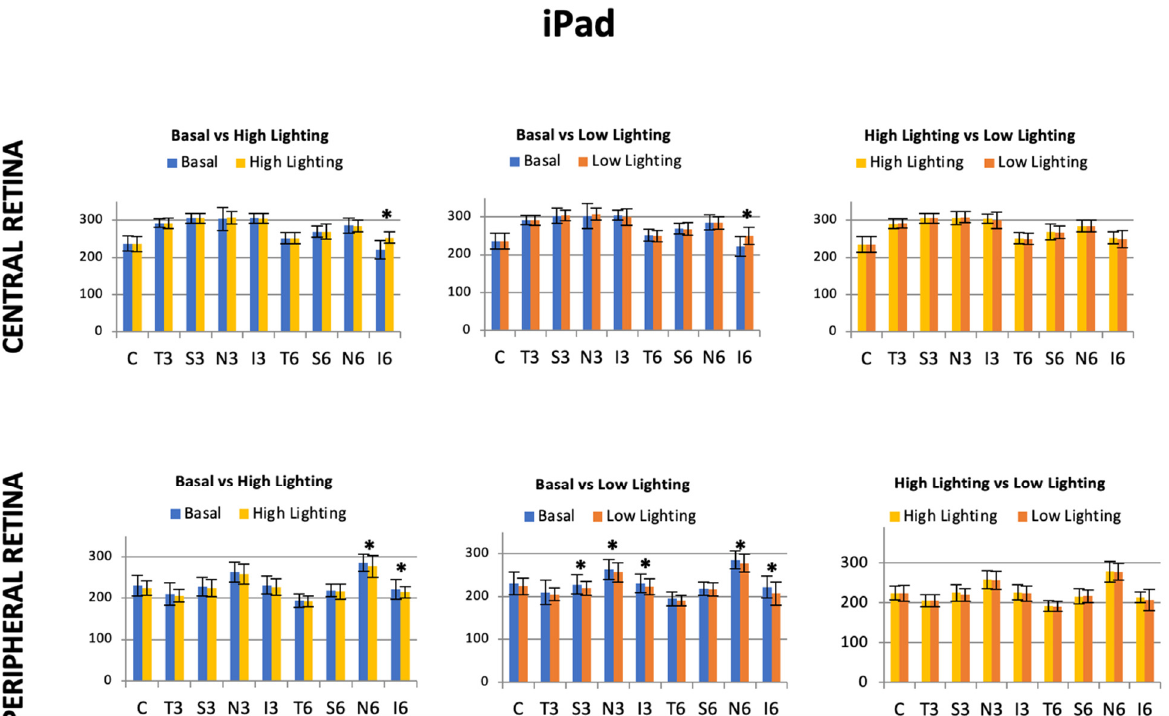
Figure 4. Mean and standard deviation (SD) of the central and peripheral retinal thicknesses (µm) in high and low lighting conditions in the nine ETDRS areas measured by 3D OCT-1000 after reading with an iPad device. Differences that reached statistical significance ( p < 0.05) are marked with *.